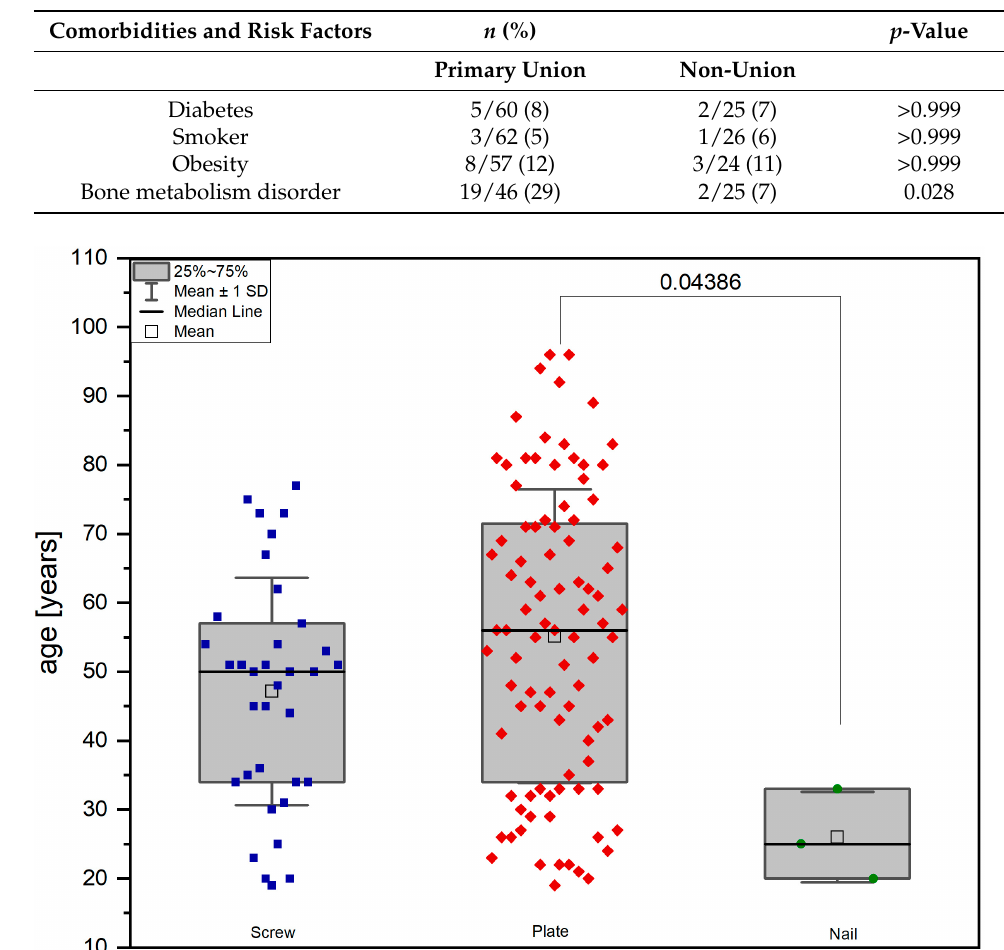
Table 1. Correlation between union and comorbidities and risk factors.